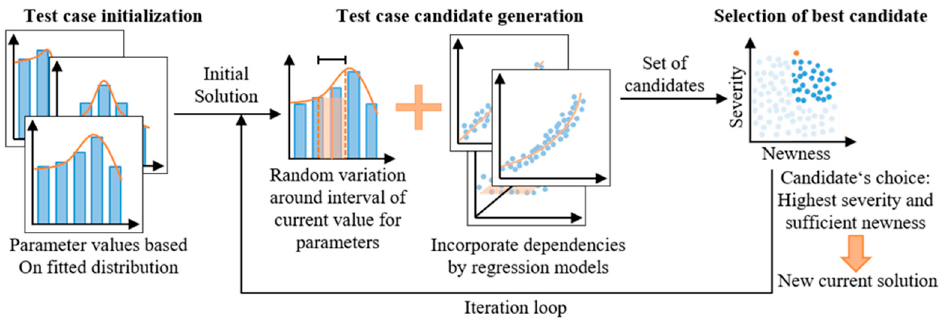
Figure 1. Procedure to assign a severity test case to the final test suite.